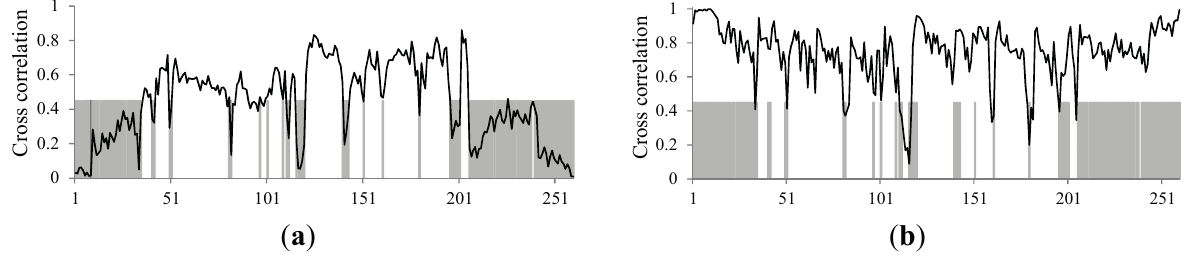
Figure 2. Relationship between compression ratio of joint-coding method and cross correlation: ( a ) residual signal and ( b ) input signal of joint channel.